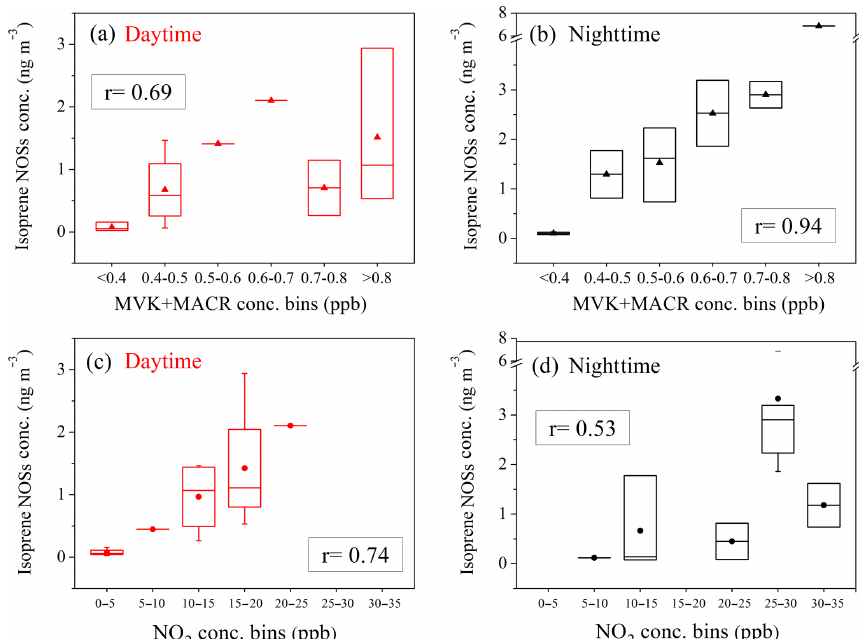
Figure 8. The isoprene NOS (C 5 H 11 NO 9 S − ) concentrations as a function of NO 2 or MVK + MACR concentration bins (ppb) and the correlations between isoprene NOSs (C 5 H 11 NO 9 S − ) and NO 2 or MVK + MACR. The closed markers in the box represent the mean values and whiskers represent 25 and 75 percentiles in each concentration bin. The r value in each panel represents the correlation coefficient between isoprene NOSs and NO 2 or MVK + MACR